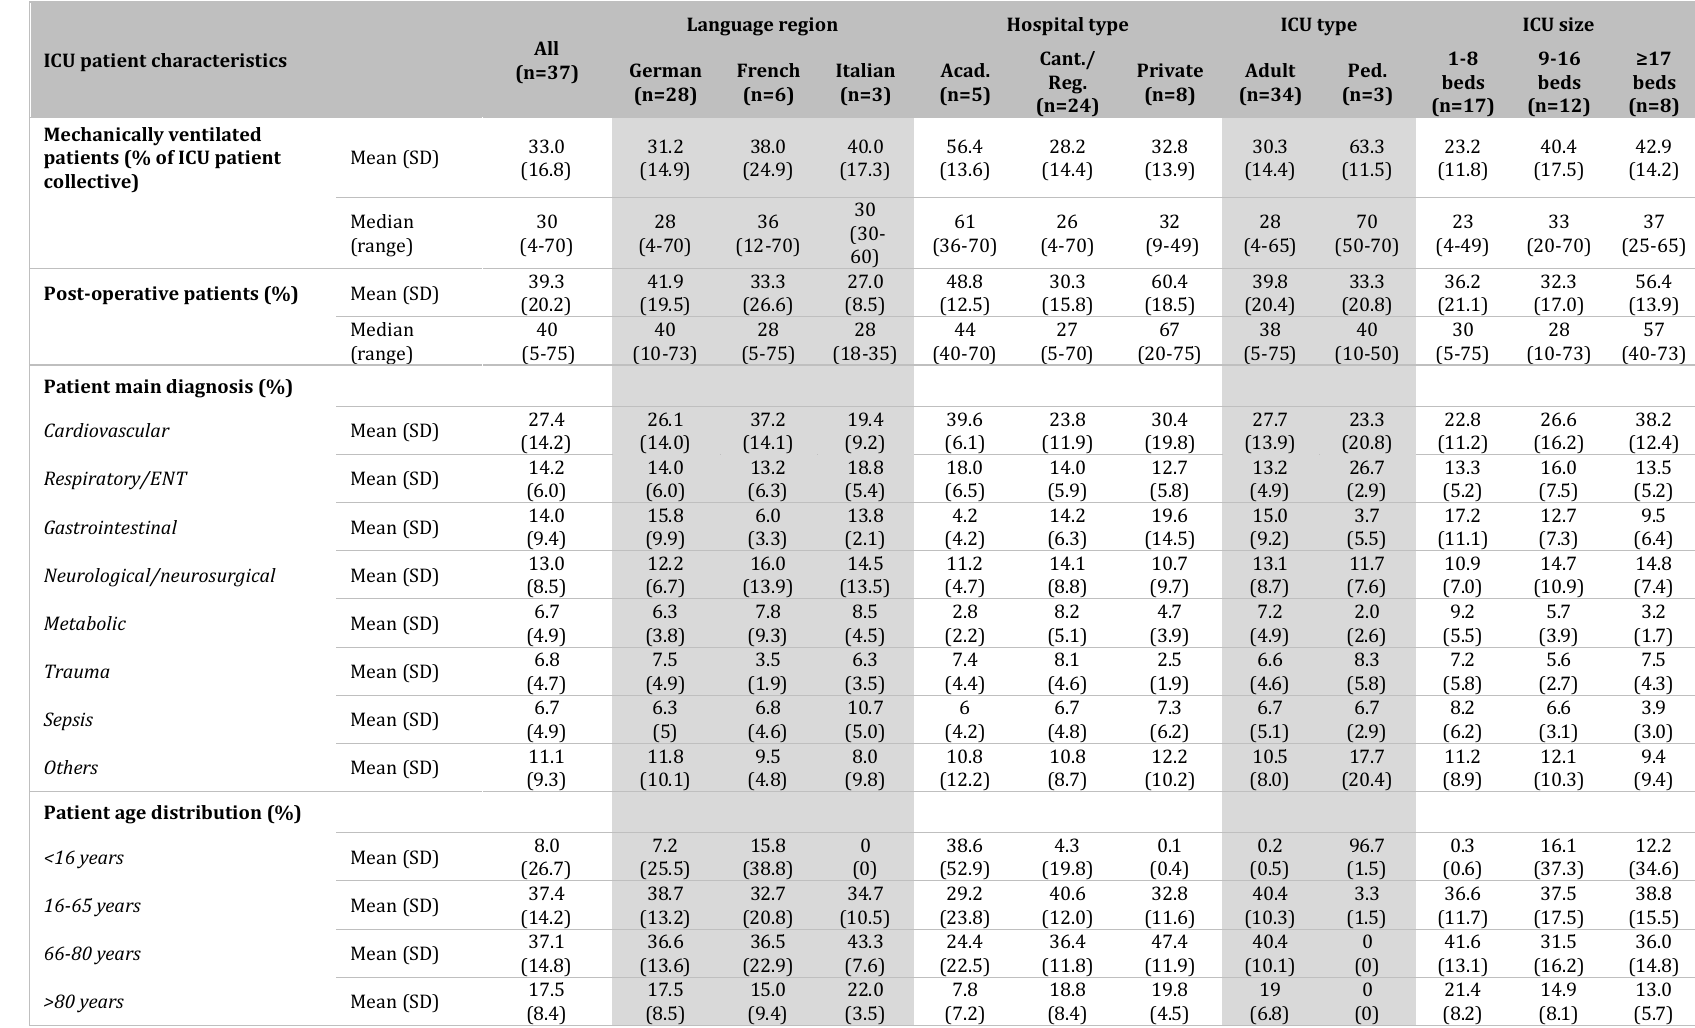
Table S3. Characteristics of patient collectives in participating intensive care units (including both adult and pediatric